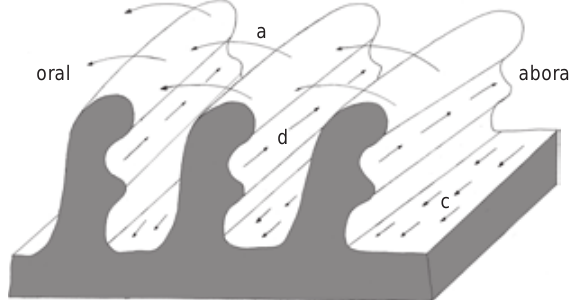
Figure 11. Macoma biota : diagram of the ciliary mechanisms on the folded surface of the labial palp, to show the various ciliary tracts. For lettering (a), (c), (d), see